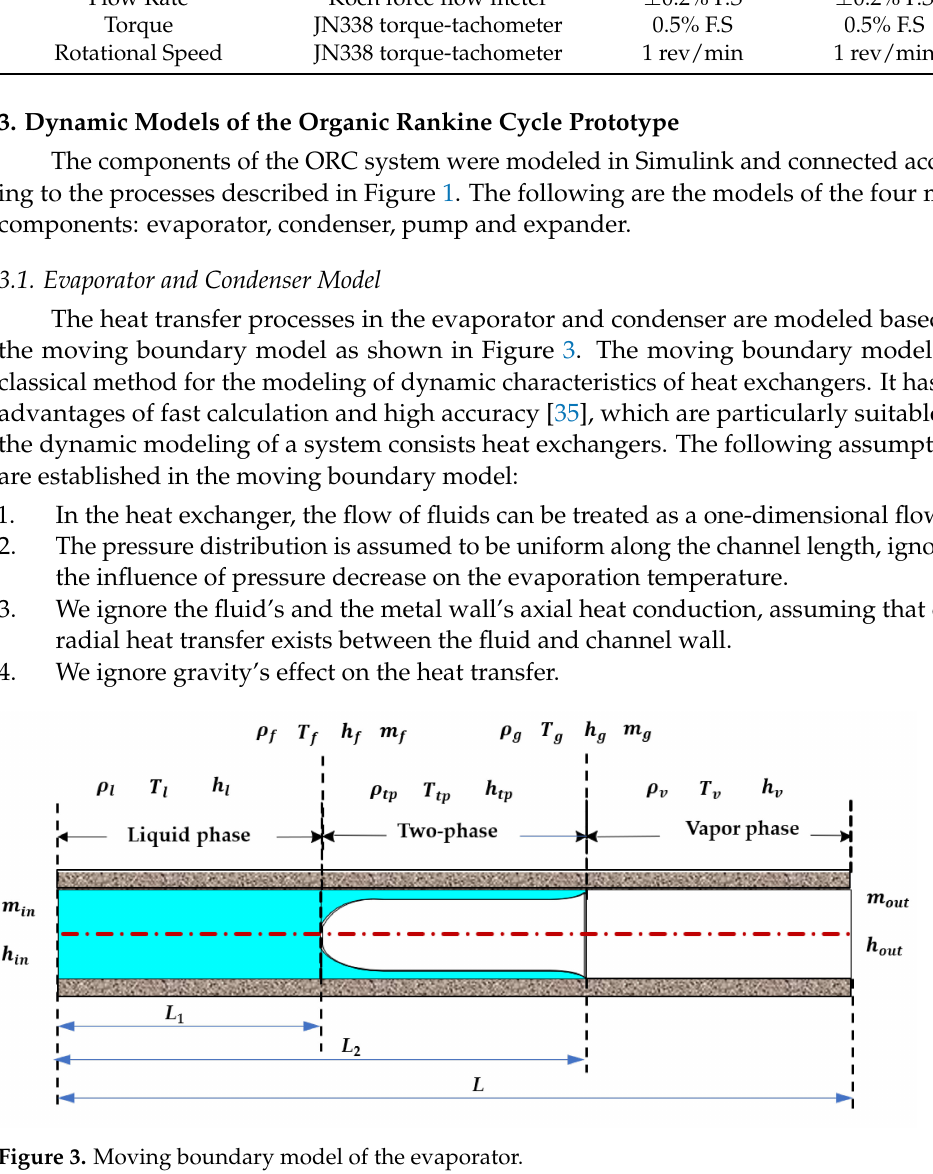
Figure 3. Moving boundary model of the